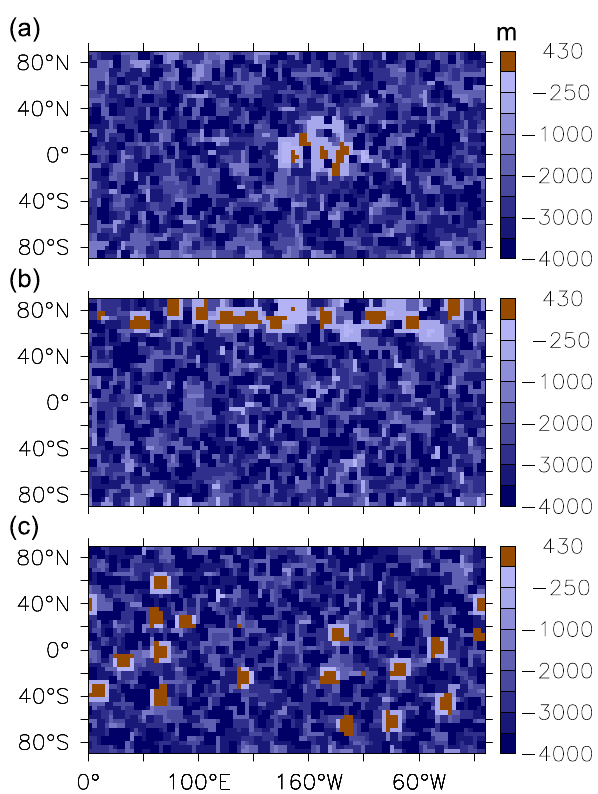
Fig. 19: Three exemplary topographies used in the uncertainty study: (a) equatorial archipelago, Fig. 19. Three exemplary topographies used in the uncertainty (b) polar archipelago and (c) a random topography with 5 % instead of 1 % emerged surface study: (a) equatorial archipelago, (b) polar archipelago and (c) a with positive topography] area. [Continents random topography with 5% instead of 1% emerged surface